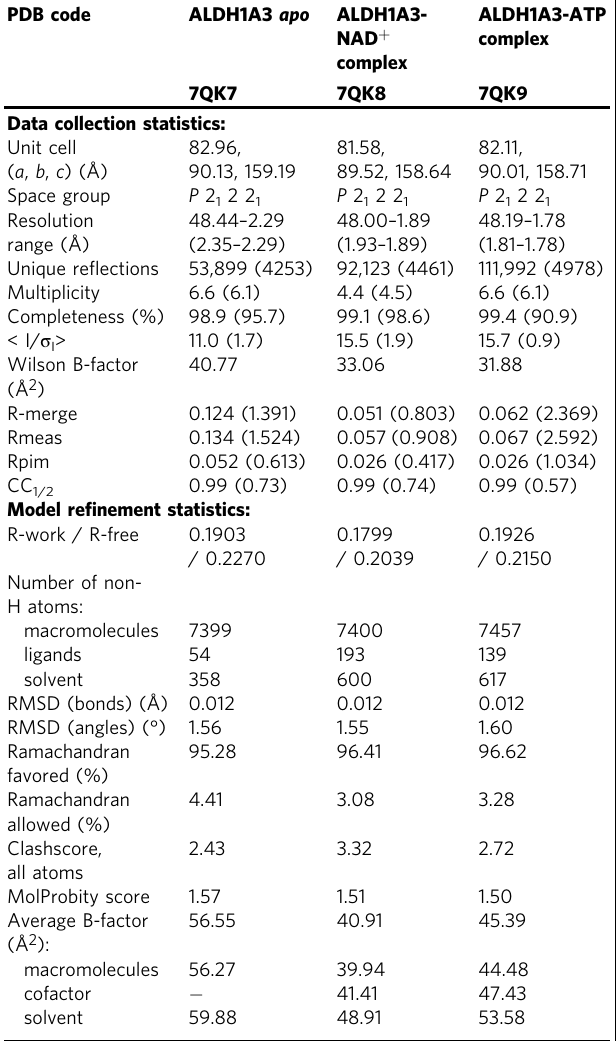
Table 1 Data collection and model re fi nement